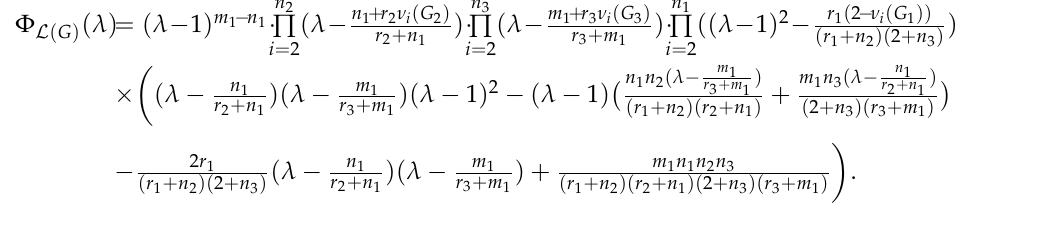
(cid:46) ( P V 2 ∪ 3,3